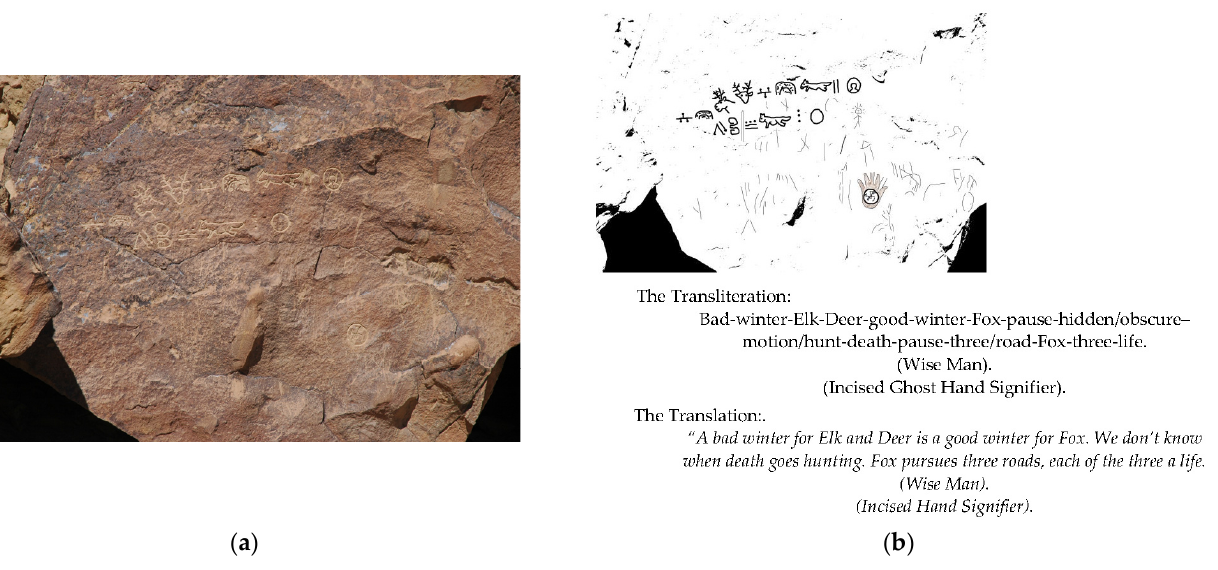
Figure 31. ( a ) Green River, Wyoming. Panel 2. ( b ) Green Riverm Wyoming. Panel 2 rendered to black and white, with tracing on photo. Transliteration of the imags from ethnographic sources, followed by proposed